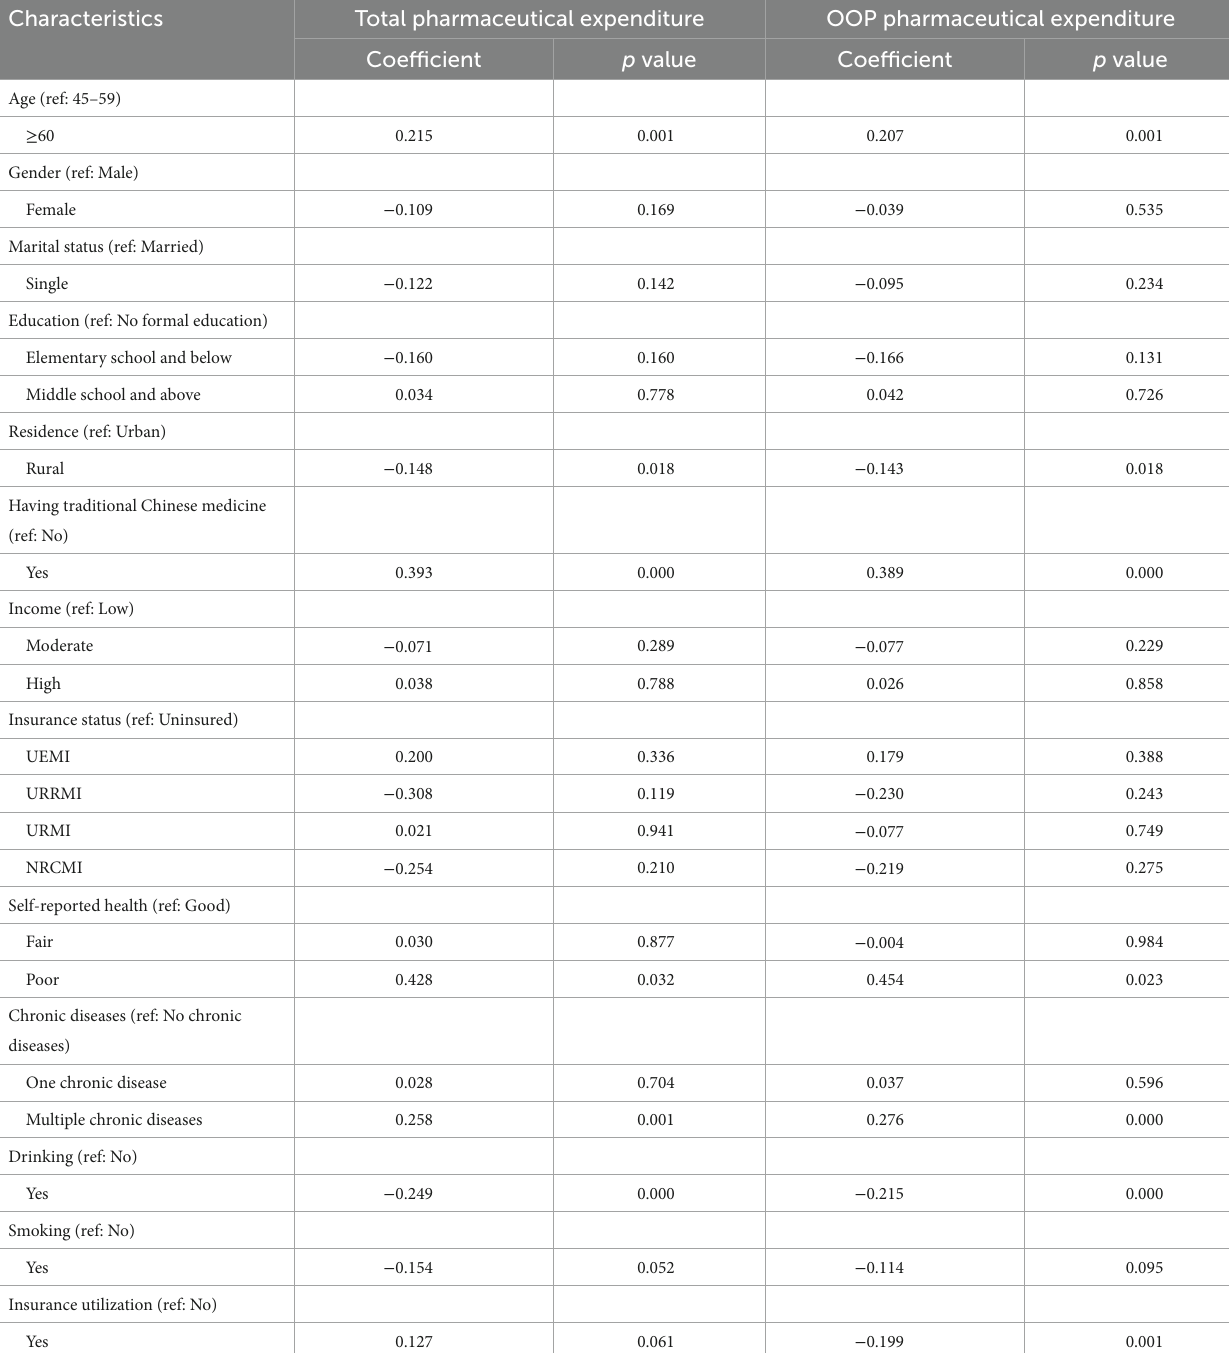
TABLE 4 Generalized linear model evaluation of the total and OOP pharmaceutical expenditure amounts of self-medication in CNY ( n = 6,094).